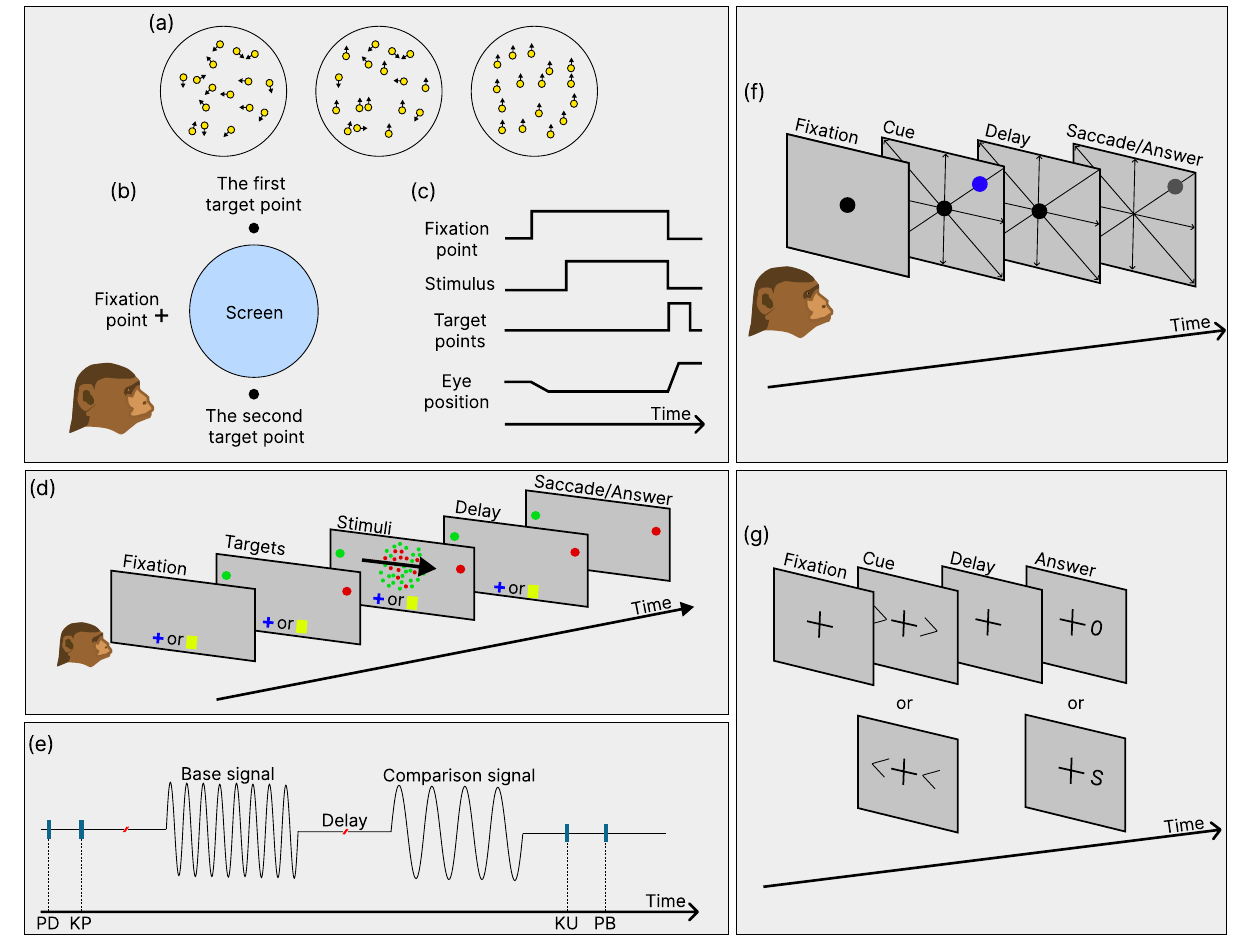
Figure 4. Schematically shown experimental prototypes of the target tasks used to train the spiking neural network: ( a )–( c ) the decision-making task, ( d ) the context decision-making task, ( e ) the working memory task, and ( f , g ) the go/no-go tasks. ( a ) Random-dot motion visual stimulus with different ratios of coherently moving dots. ( b ) A monkey observing the screen and the positions of the fixation and target points. ( c ) Sequence of events during the trial. The figure is modified from 38 . ( d ) Context decision-making task 16 . First, the context signal turns on (blue cross or yellow square), and then two target (red and green) points appear. After that, a random-dot diagram is shown with a controlled predominant color and the direction (described by an arrow) of coherently moving dots. After the delay period, the animal is expected to respond by using saccadic eye movements to follow the preferential color or direction depending on the context signal. ( e ) Working memory Romo task 37 . First, the probe is placed in the monkey’s hand (PD); then, the monkey places its free hand on a stationary key (KD), after which two vibrotactile stimuli with different frequencies are given separated by a delay. Finally, the monkey releases the key (KU) and presses one of two push buttons to indicate its choice of which stimulus had a higher frequency (PB). ( f ) Example of the go/no-go task 35 . First, the fixation point is highlighted on the screen, and then a cue appears at one of 8 or 4 peripheral locations. After the delay period, the monkey is expected to saccade to the indicated target. ( g ) Example of the go/no-go task 39 . First, human subjects are presented with a fixation visual stimulus, and then one of two possible cues is turned on. After the delay period, the go or no-go signal appears, indicating whether the subject should or should not press the corresponding button in their